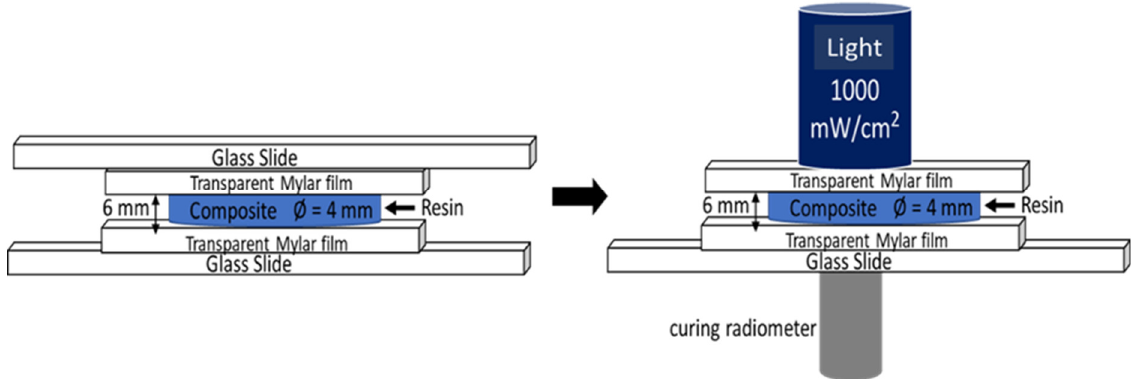
Figure 1. Schematic representation of the depth of cure analysis on